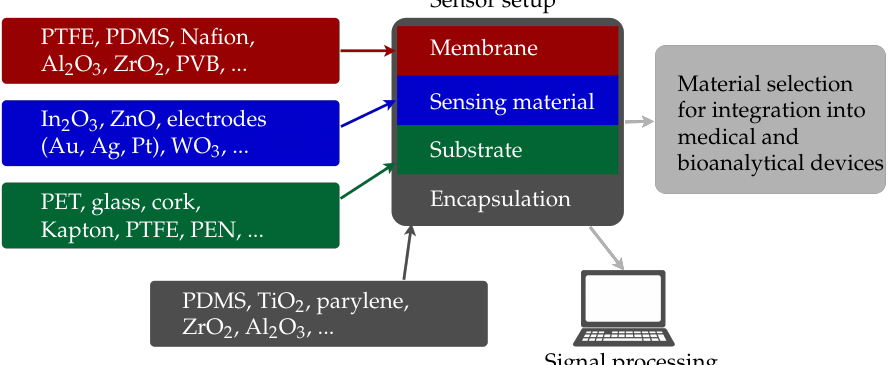
Figure 3. Schematic of a basic sensor structure, which consists of a membrane, sensing material, substrate, and encapsulation. The materials are employed in regard to integrate the sensor in medical and bioanalytical